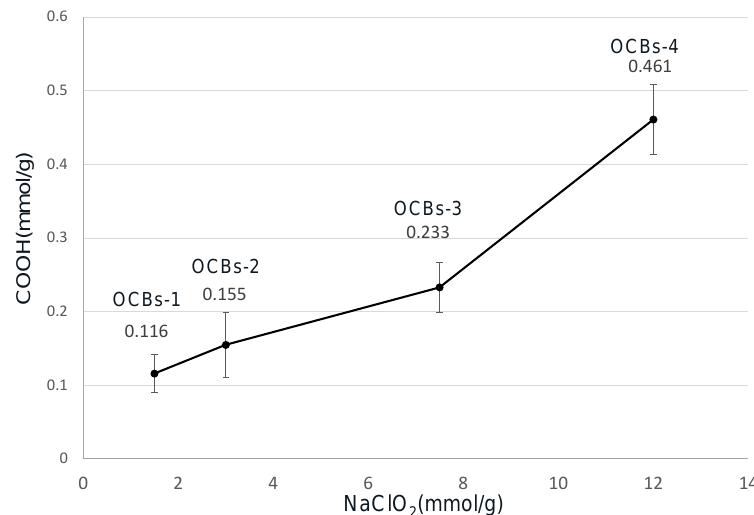
Figure 1. Effect of varying molar ratio of NaClO 2 on – COOH content.